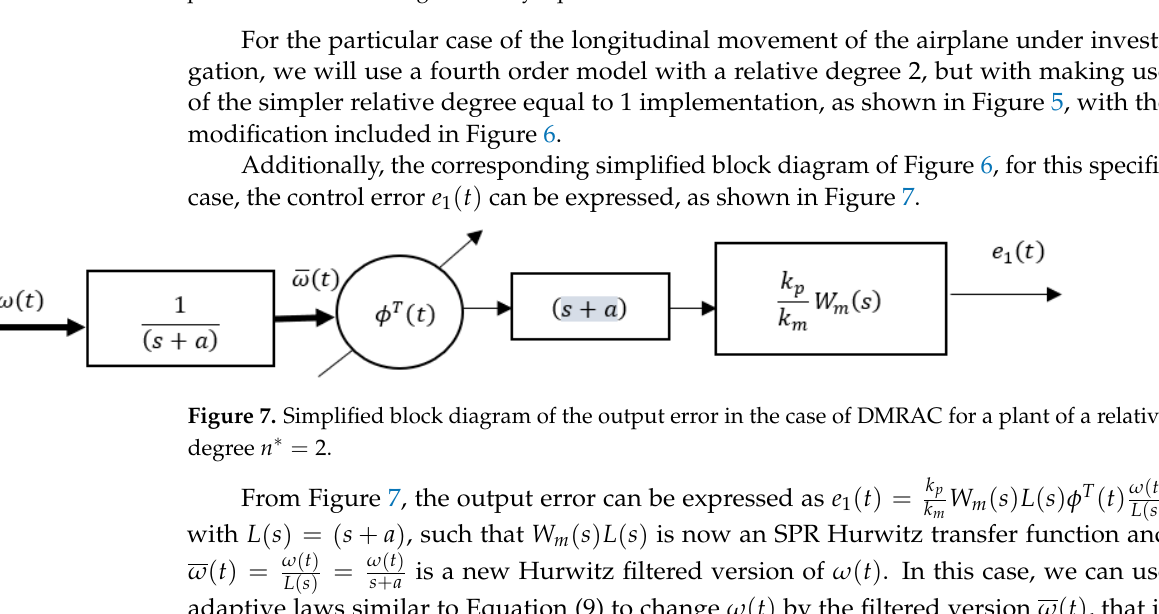
Figure 6. Block diagram associated to the output error 𝑒 (cid:2869) (𝑡) valid only for the case of an n th order plant with a relative degree exactly equal to 2.